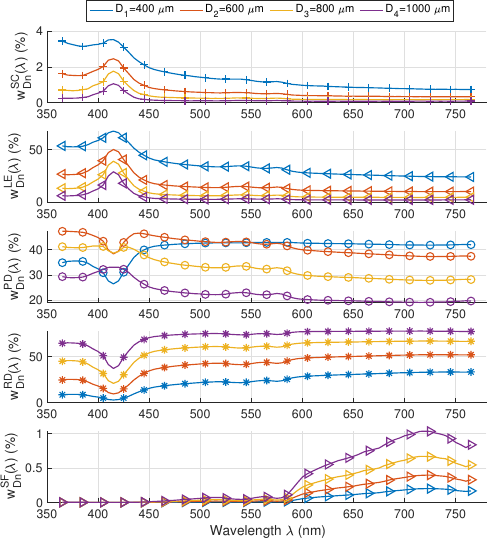
Figure 12. Weight of each layer (from SC at the top to SF at the bottom) in DR signal according to Equation (5) for distances D 1 – D 4 in the healthy skin model with intermediate thicknesses of SC and LE layers, mean dermal blood content and phototype I. The correspondence between symbols and layers is still the same as indicated in Figure